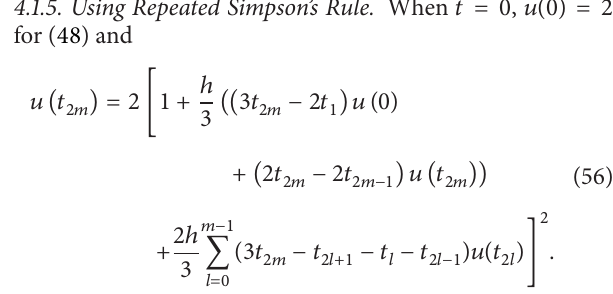
The solution to (48) using repeated Simpson’s rule is shown in Figure